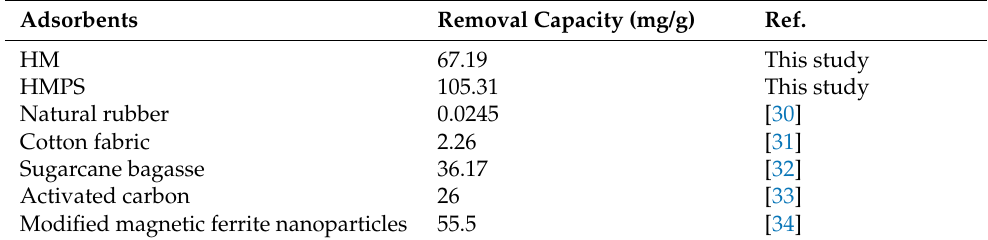
Table 3. Comparison of removal capacity of HMPS with previously reported adsorbents for adsorp- tion of direct violet 51 dye.